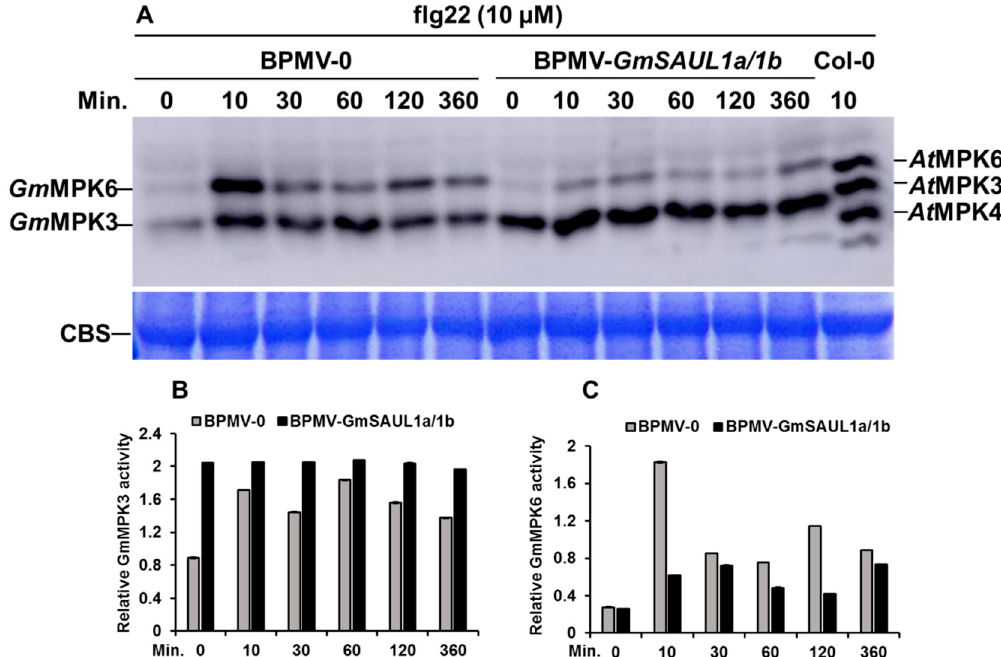
Figure 5. Silencing GmSAUL1a/1b reduces the activation of Gm MPK6 and enhances the activation Gm MPK3 in response to flg22 treatment. ( A ) Leaf discs from both BPMV-0 and BPMV- SAUL1a/1b plants were incubated on the moisture filter paper for 24 h to allow recovery from wounding before being treated with 10 µ M flg22 or diluted DMSO over the indicated times. Activation of the kinase activities was detected by Western blotting using the Phosph-p44/p42 MAP Erk1/2 antibody. Arabidopsis sample treated with 10 µ M flg22 for 10 min was used as a positive control for the purpose of band alignment. Coomassie Blue stained gel (CBS) was used as loading controls. ( B ) Relative Gm MPK3 activity shown in ( A ). ( C ) Relative Gm MPK6 activity shown in ( A ). Relative activity was calculated as the band intensities on the Western blot divided by the corresponding band intensities on the CBS